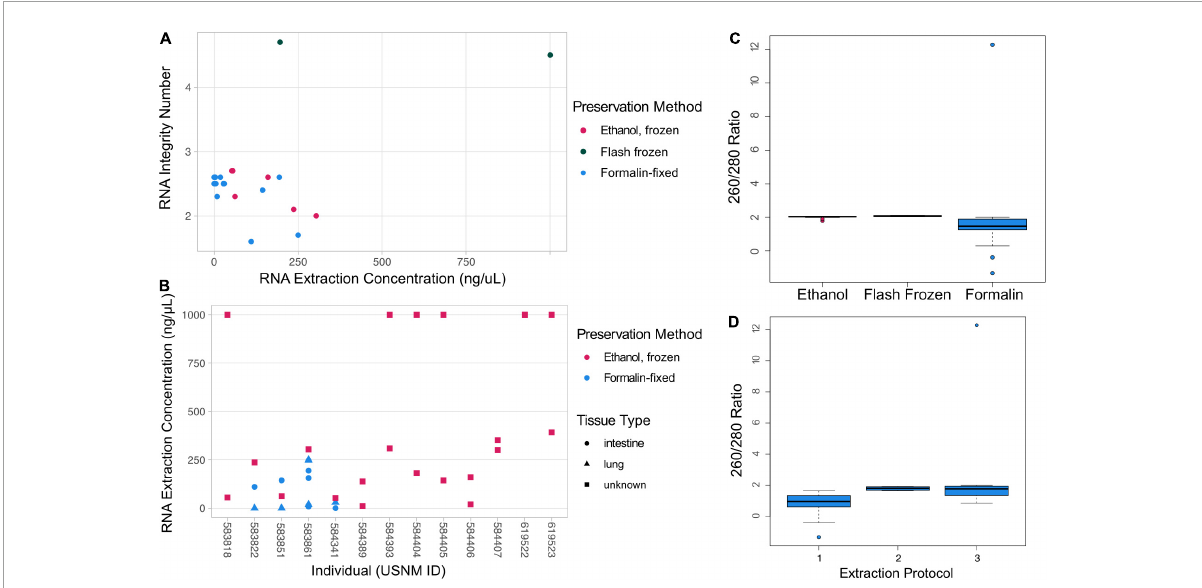
FIGURE2 RNA Quality and Quantity. (A) RNA extraction concentration by RIN for different sample types with preservation method indicated by color. (B) Plot of the RNA extraction concentrations for individual bats (NMNH identification number, USNM ID) that had duplicate tissue samples taken. In this plot preservation is mapped as color and tissue type is indicated by shape. In both (A,B) plots, samples that have an indicated concentration of 1,000 ng/ µ L were above the detection threshold of the Qubit HS Kit and should be interpreted as having at least 1,000 ng/ µ L concentrations. (C) Estimate of RNA purity using Nanodrop 260/280 ratio compared to preservation of tissues used for extractions. (D) Comparison of Nanodrop 260/280 ratio across protocols used to extract RNA from formalin-fixed tissues. A 260/280 ratio of ∼ 2